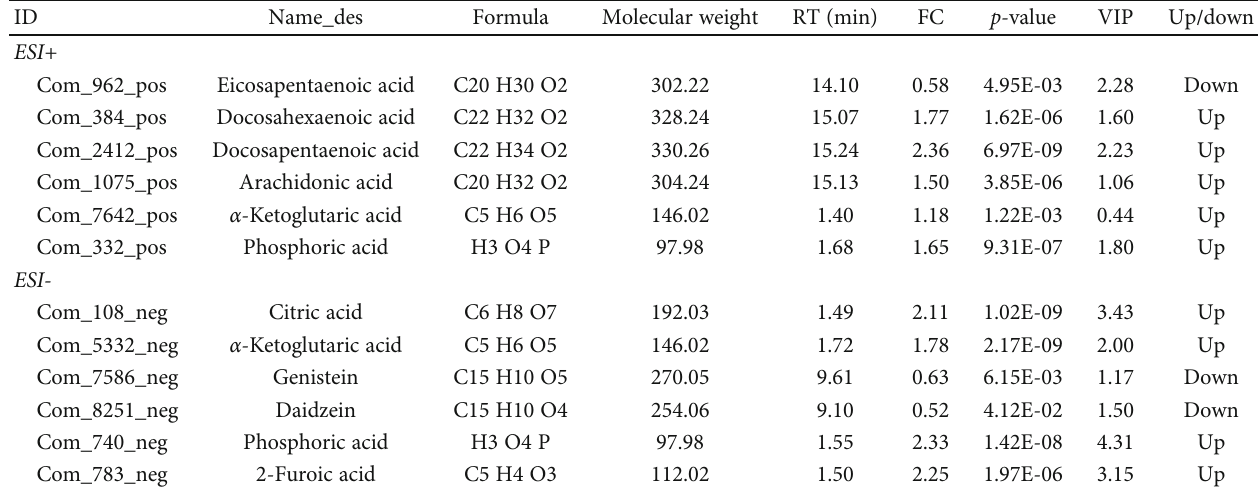
Table 2: Ten major di ff erential metabolites for future analysis.